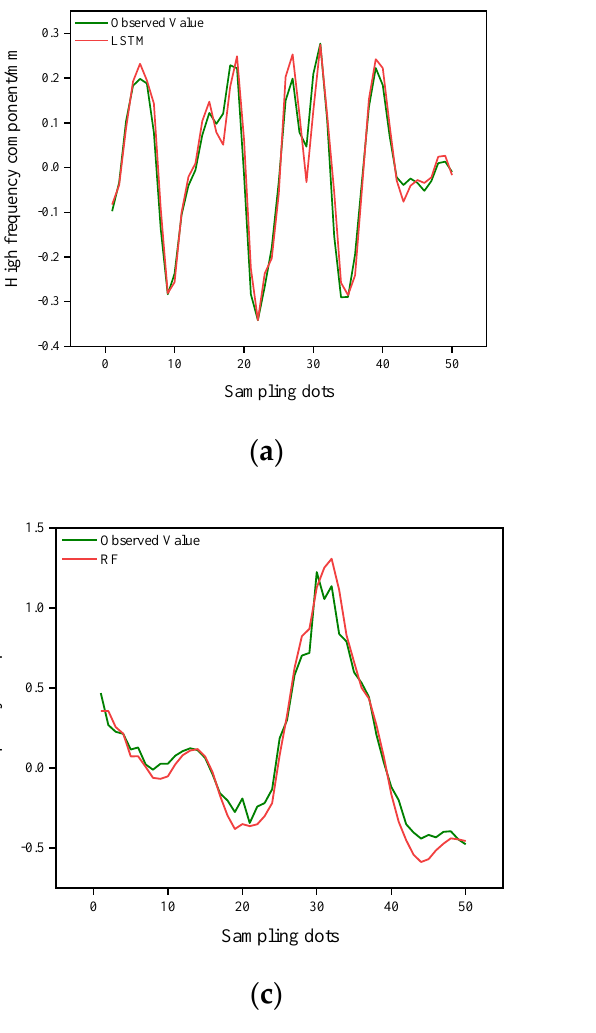
Figure 10. Measurement point EX2 high and low frequency prediction and correlation coefficient. (( a ) High frequency prediction; ( b ) Linear regression analysis of LSTM; ( c ) Low frequency prediction; ( d ) Linear regression analysis of RF)